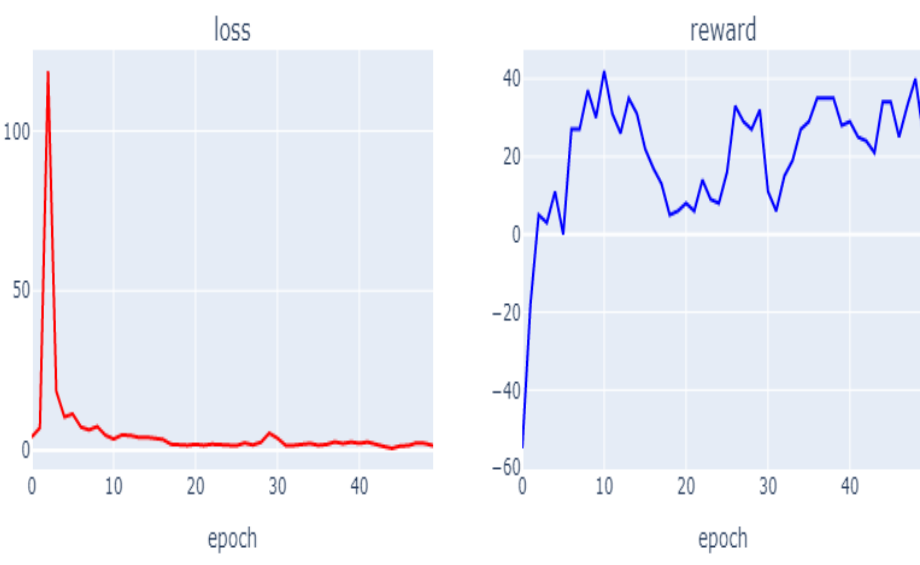
Figure 14. Learning results by substituting the Quad Q Network algorithm based on the proposed Total Resource on Apple.